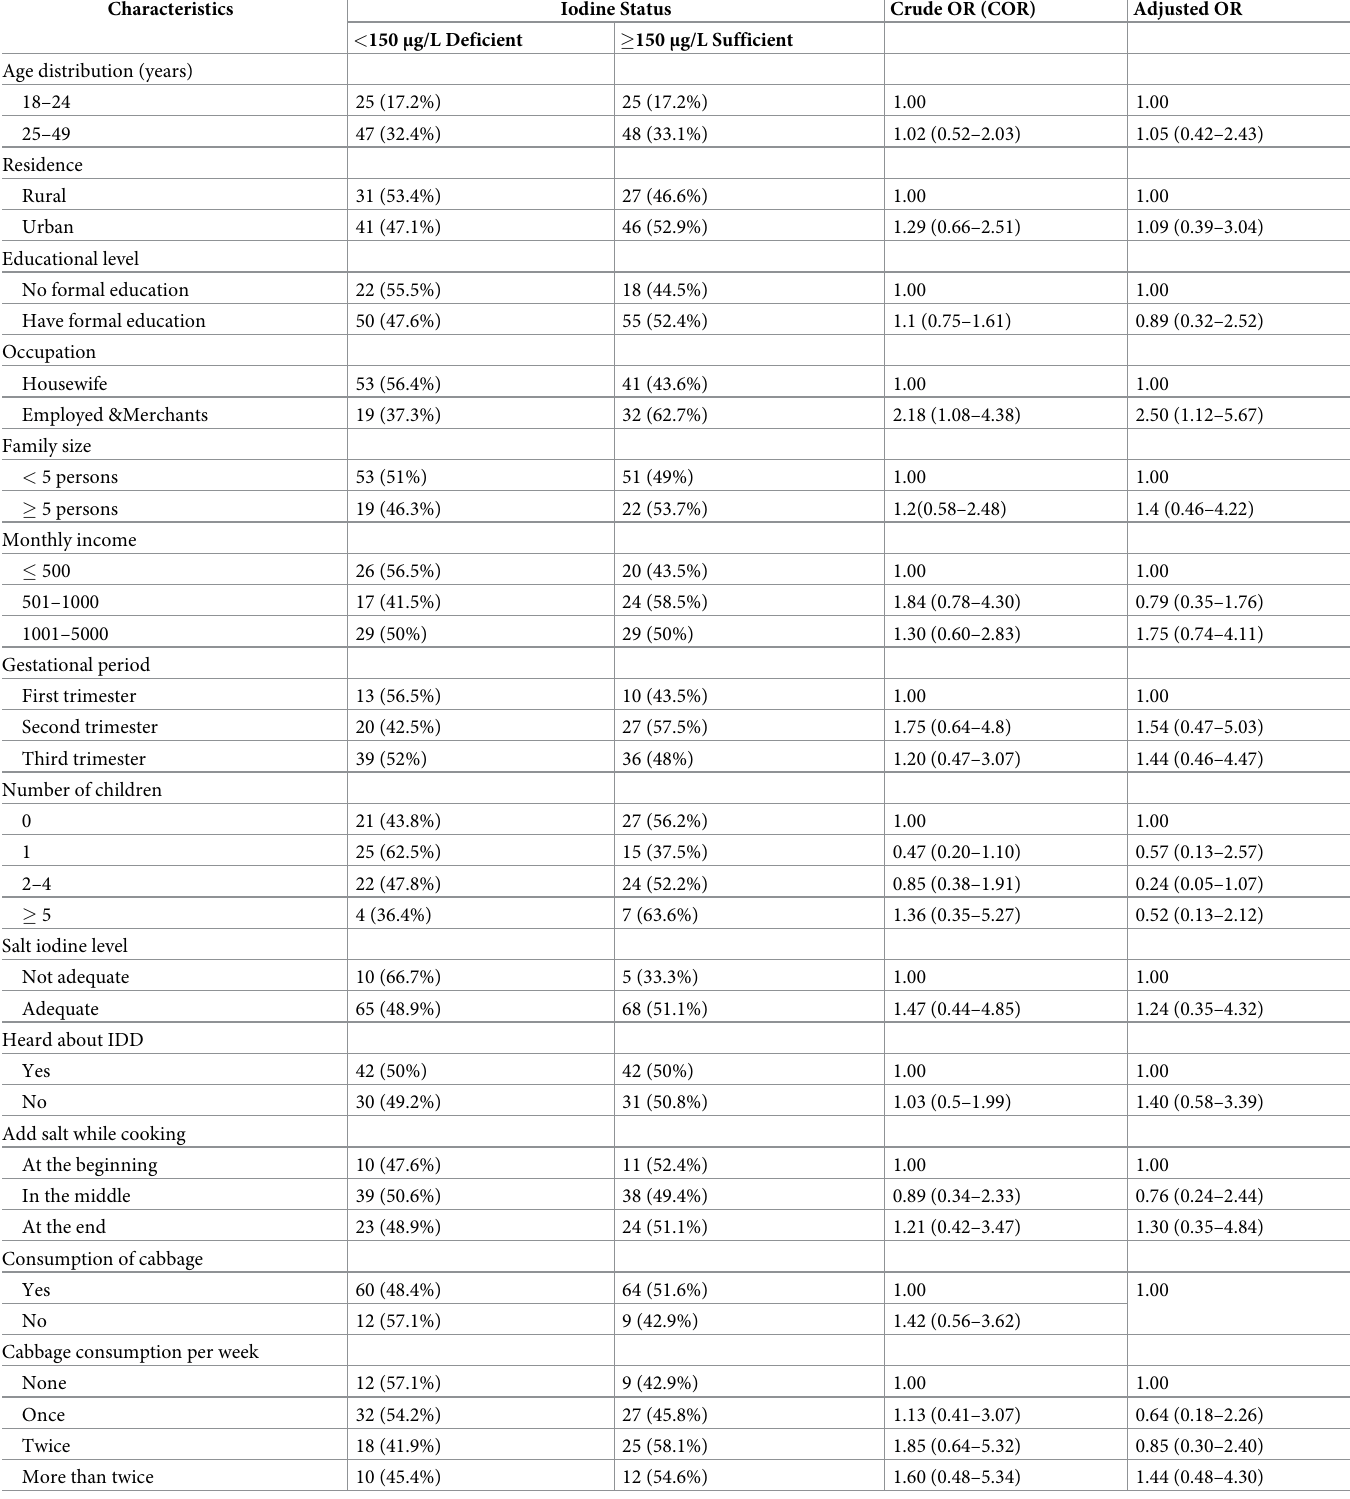
Table 4. Multivariate logistic regression analysis on factors associated with iodine status of pregnant women (N = 145) in BUNMAP cohort study, Butajira, Ethio- pia, February,